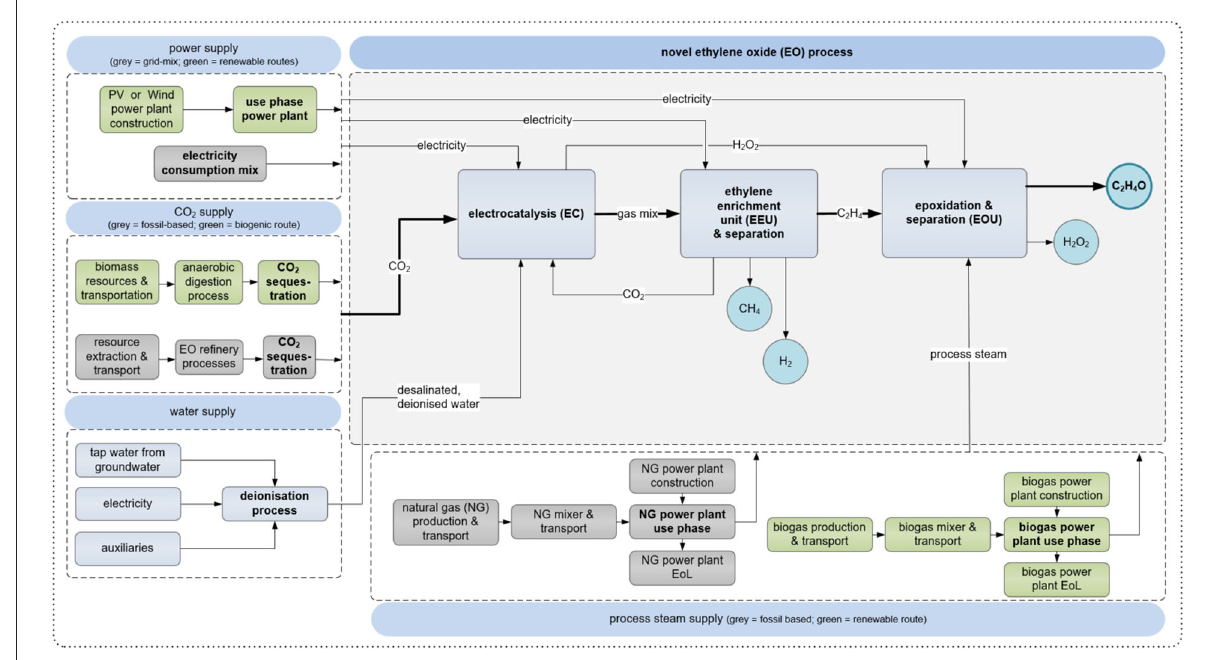
FIGURE4 System boundaries and scheme of the assessed process. For electricity generation, CO 2 supply and process steam supply conventional (gray) and renewable (green) pathways exist. The electrocatalysis and EEU are modeled based on our data and the epoxidation based on (Ghanta et al., 2013) while the supply processes are taken from GaBi sphera with one exception: the biogas upgrading process (CO 2 sequestration) was modeled based on (Zhang et al., 2020). Impact allocation was based on mass. Source: Own illustration based on own data and